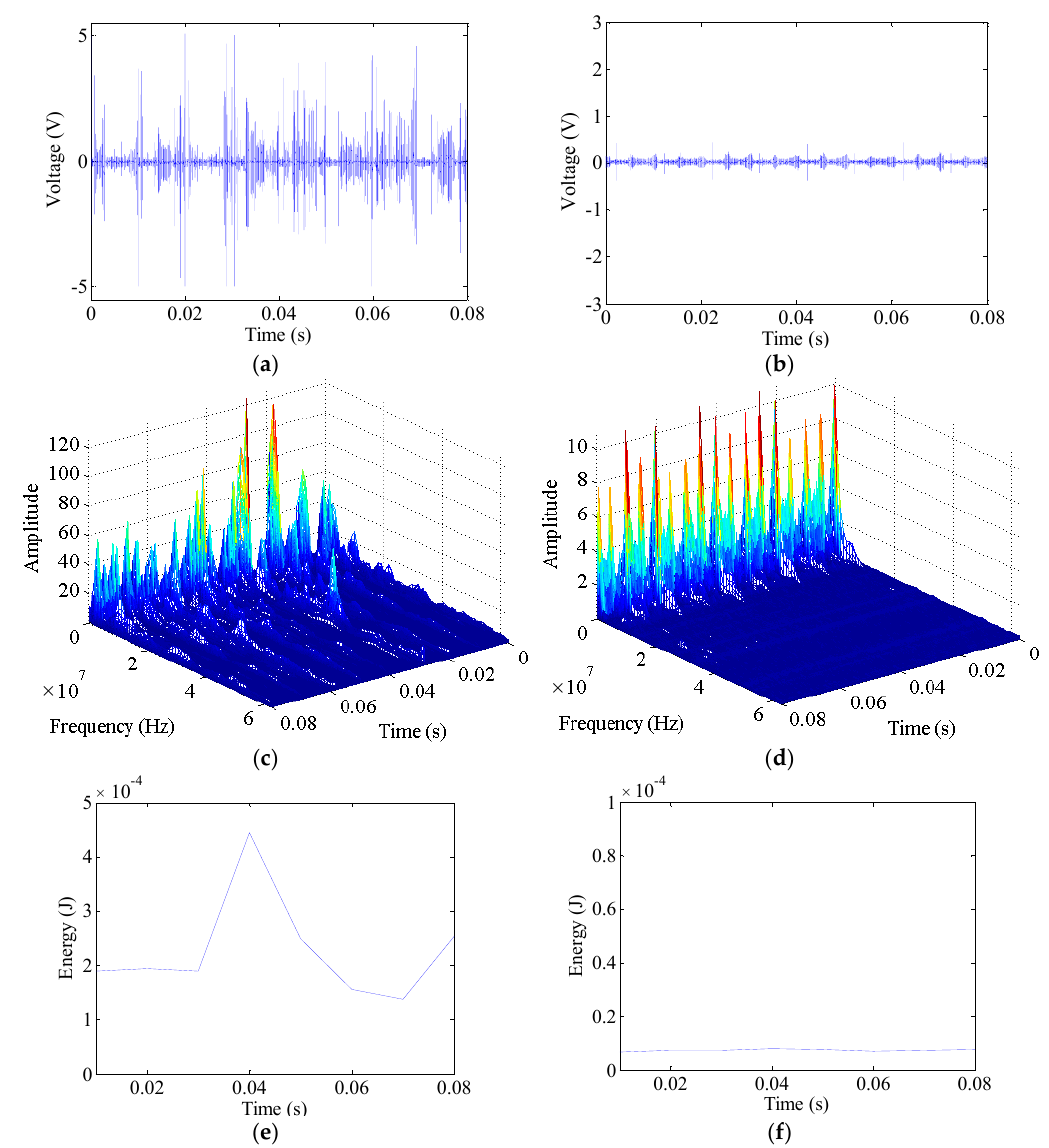
Figure 8. Signal analysis of a vacuum cleaner: ( a ) high-frequency signals of arc faults; ( b ) high-frequency signals under normal operation; ( c ) signals’ STFT of arc fault signals; ( d ) signals’ STFT under normal operation; ( e ) high-frequency energy of arc faults; ( f ) high-frequency energy under normal operation.